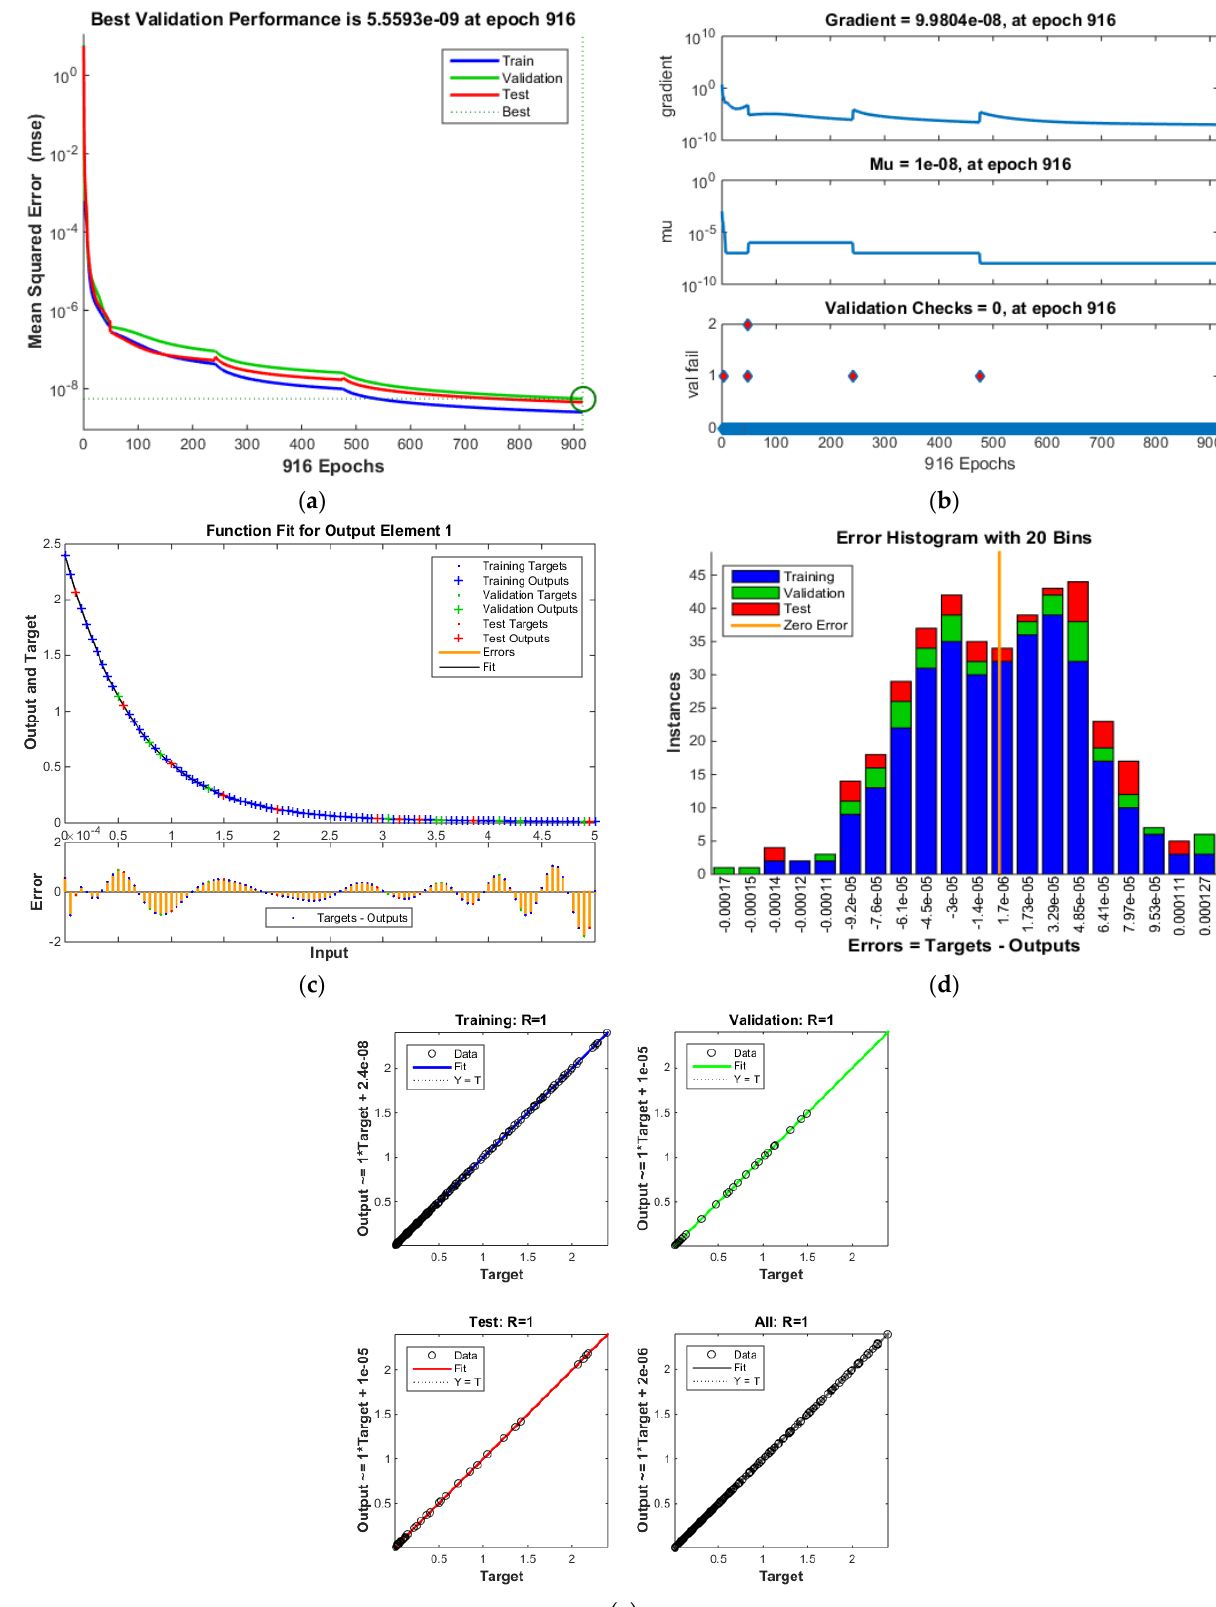
Figure 4. Graphic representation for LMT-ABPNN base on variants of 𝛽 for 𝑓′(𝜂) of MHD-SGFM. ( a ) MSE representation, ( b ) Results of the transition state, ( c ) Fitness of the curve, ( d ) Histogram for error analysis, ( e ) Regression.